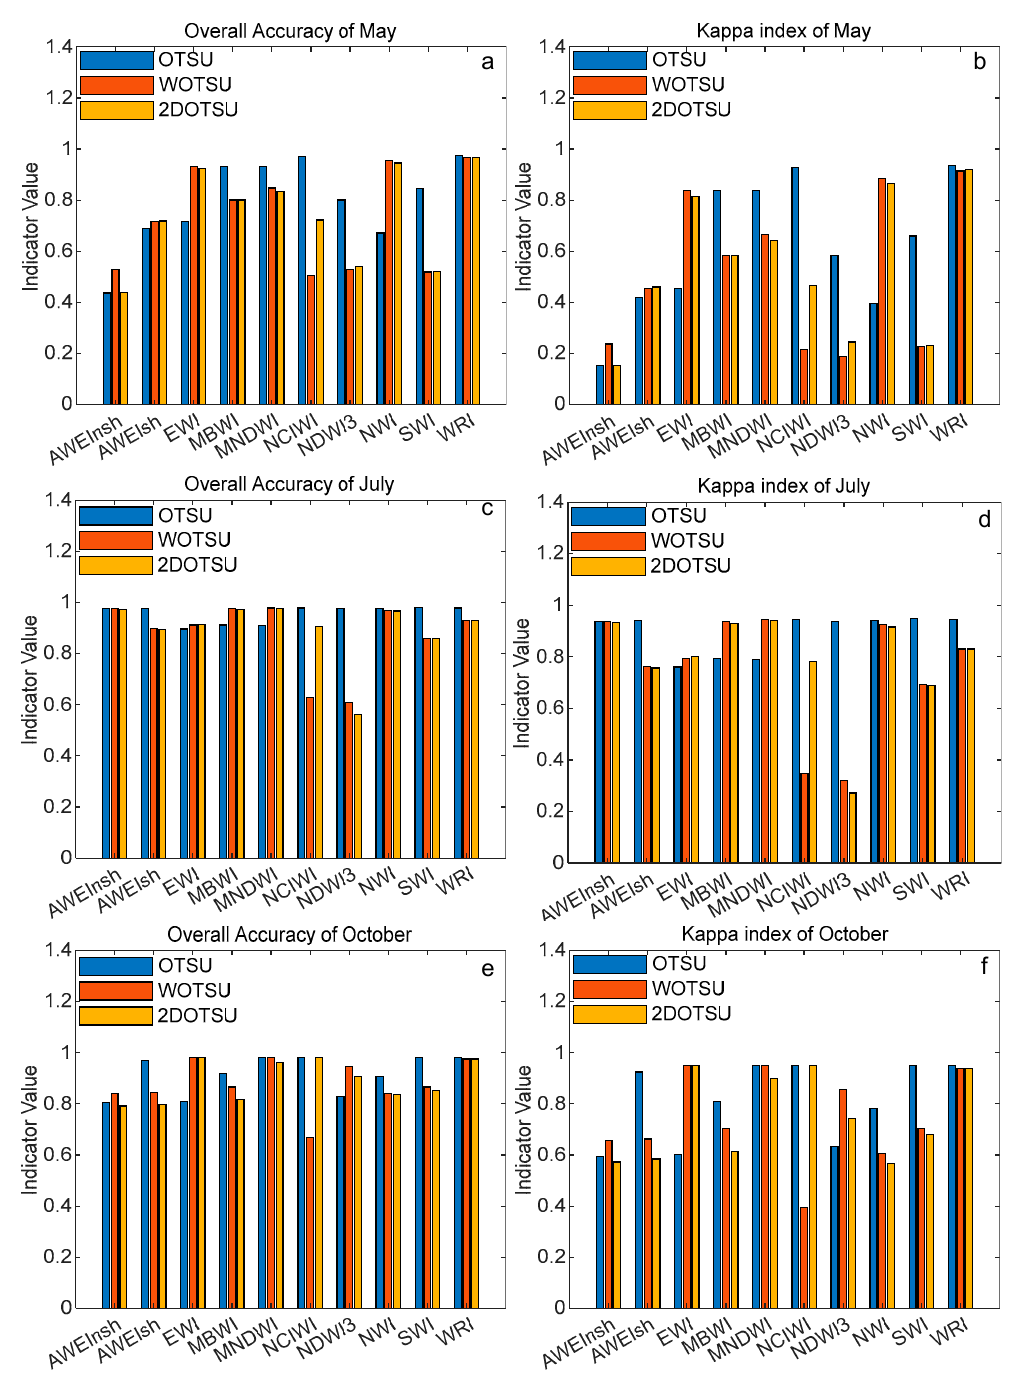
Figure 9. Evaluation charts of OA ( a , c , e ) and Ka ( b , d , f ) of water extraction experiments for water indices of different water periods based on the optimal segmentation thresholds obtained by the three adaptive algorithms in the study area of Songhua Lake.